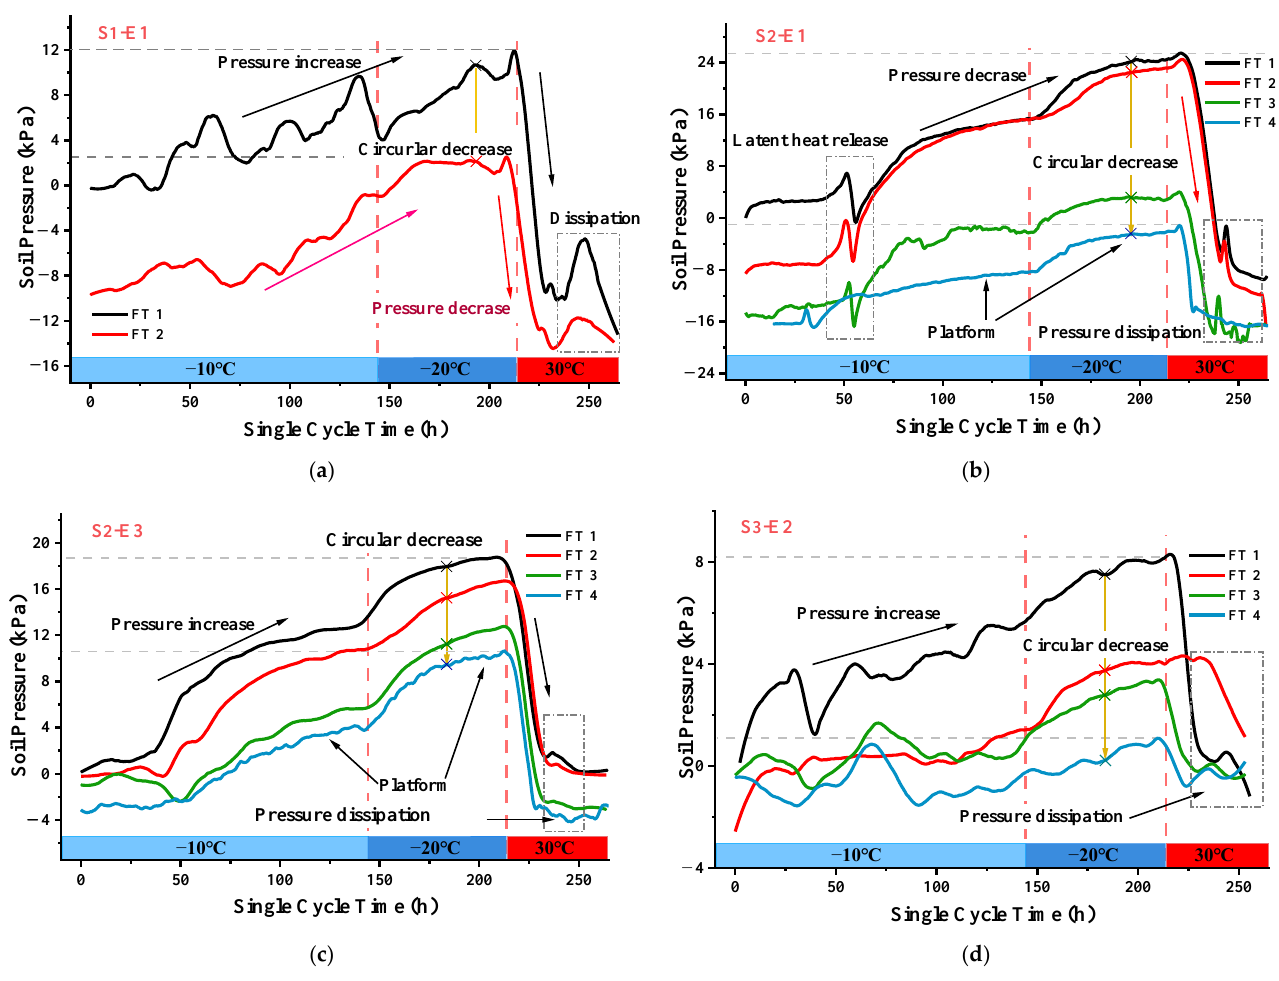
Figure 10. Soil pressure of the slope model in four freeze – thaw cycles. ( a ) S1-E1; ( b ) S2-E1; ( c ) S2-E3; ( d ) S3-E2.